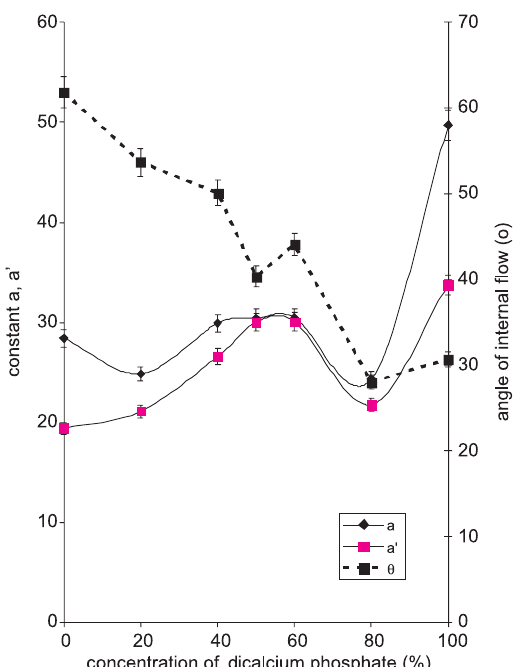
FIGURE 2 - Powder characteristics as a function of the concentration of dicalcium phosphate in binary mixtures with chloroquine phosphate